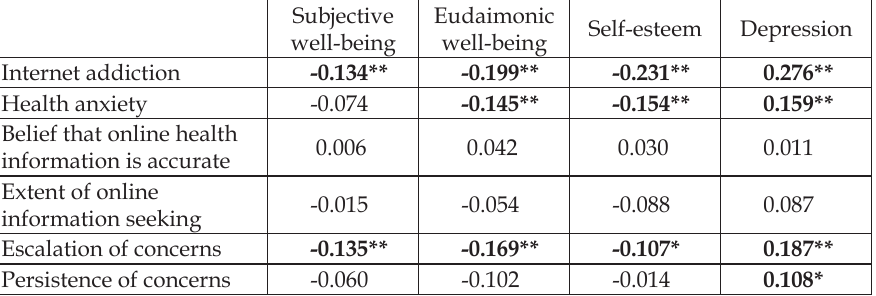
Table 3. Results from correlation analyses of the relationships between Internet addiction, health anxiety, cyberchondria, well-being, self-esteem and depression Subjective Eudaimonic Self-esteem Depression well-being well-being Internet addiction -0.134** -0.199** -0.231**